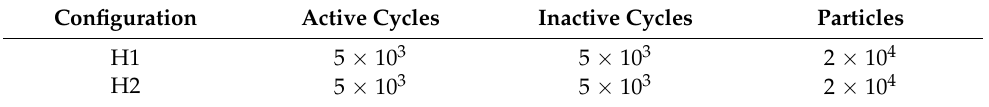
Table 16. Numerical simulation parameters for CROCUS configurations during forward simulations.